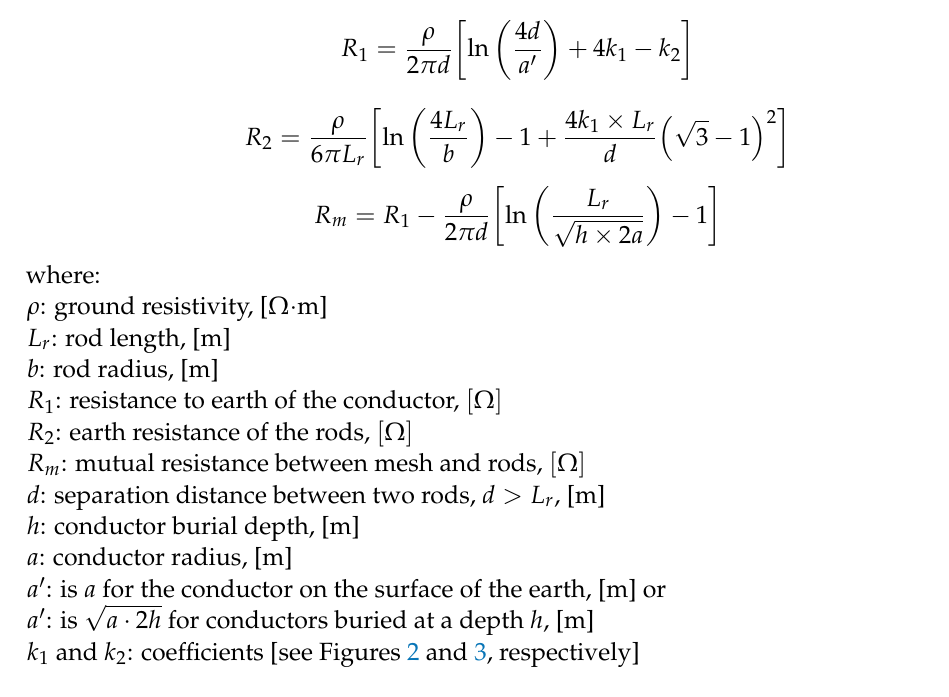
CURVE A - FOR DEPTH h = 0 y A = 0.15x+5.50 CURVE B - FOR DEPTH h = 1/10 √ AREA y B = 0.10x+4.68 CURVE C - FOR DEPTH h = 1/6 √ AREA